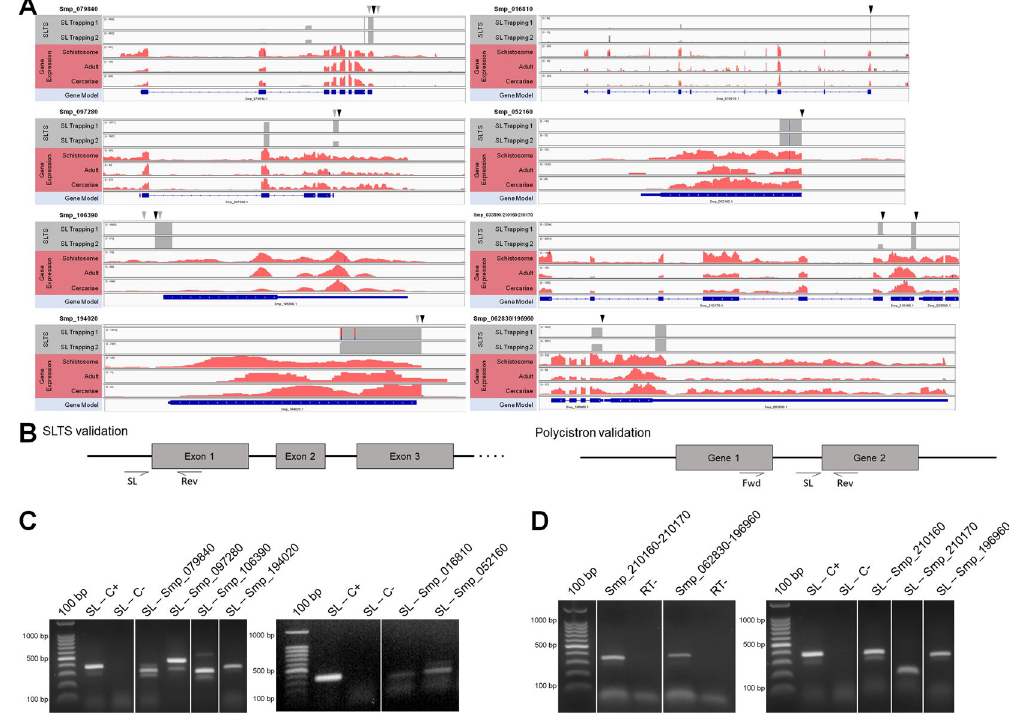
Figure 2. SL insertion sites and validation of novel trans-spliced transcripts. ( A ) Genome browser view of the exon-intron structure of genes undergoing SLTS, with the superimposed coverage for the SL Trapping 1 and 2 datasets (gray - top tracks) and the RNA-Seq dataset (pink - middle tracks). Black arrows show SL insertion sites and gray arrows show secondary SL insertions sites. The structure of genes with high (Smp_079840, Smp_097280, Smp_106390 and Smp_194020) and low read counts (Smp_016810 and Smp_052160), as well as the gene structure of a tricistronic transcript constituted by the genes Smp_033590, Smp_210160 and Smp_210170, and a dicistronic transcript, constituted by the genes Smp_062830 and Smp_196960, are shown. ( B ) Schematic view of genes validated by RT-PCR with the primers annealing sites. The expected fragment sizes were described in Table S1. ( C ) RT-PCR validation of trans-spliced genes with SL as forward primer and a gene-specific reverse primer. The Smp_024110 and Smp_045200 genes were included as positive and negative control, respectively, previously reported in 20 . ( D ) RT-PCR validation of two polycistrons by two PCR reaction: with SL as the forward primer and a gene-specific reverse primer and with gene specific primers from upstream and downstream genes. Controls without reverse transcriptase were used for each of the reactions to show the absence of gDNA contamination. Full-length gels are presented in Supplementary Figure S5 A, B and